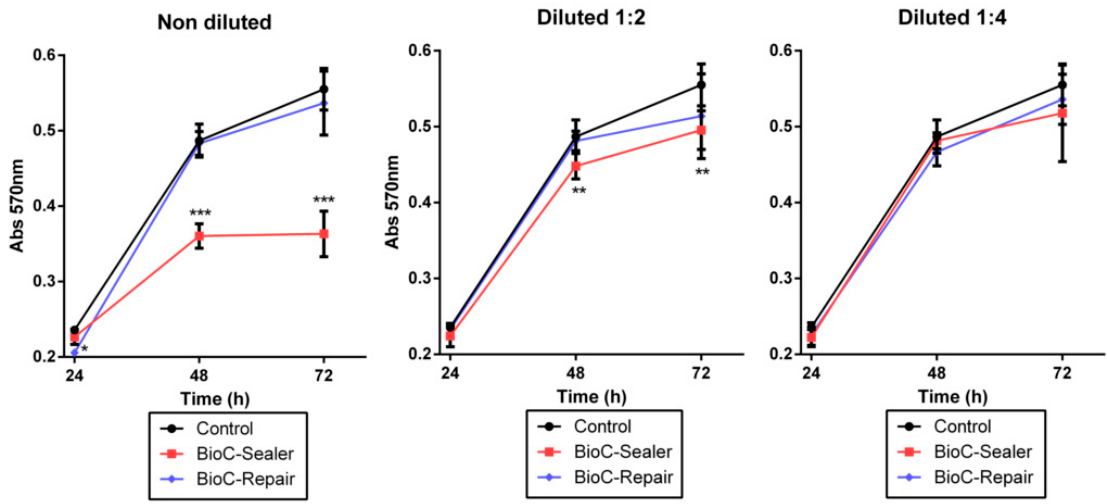
Figure 2. Viability of periodontal ligament stem cells incubated in the presence of different endodontic cement extracts (* p < 0.05; ** p < 0.01; *** p < 0.001,